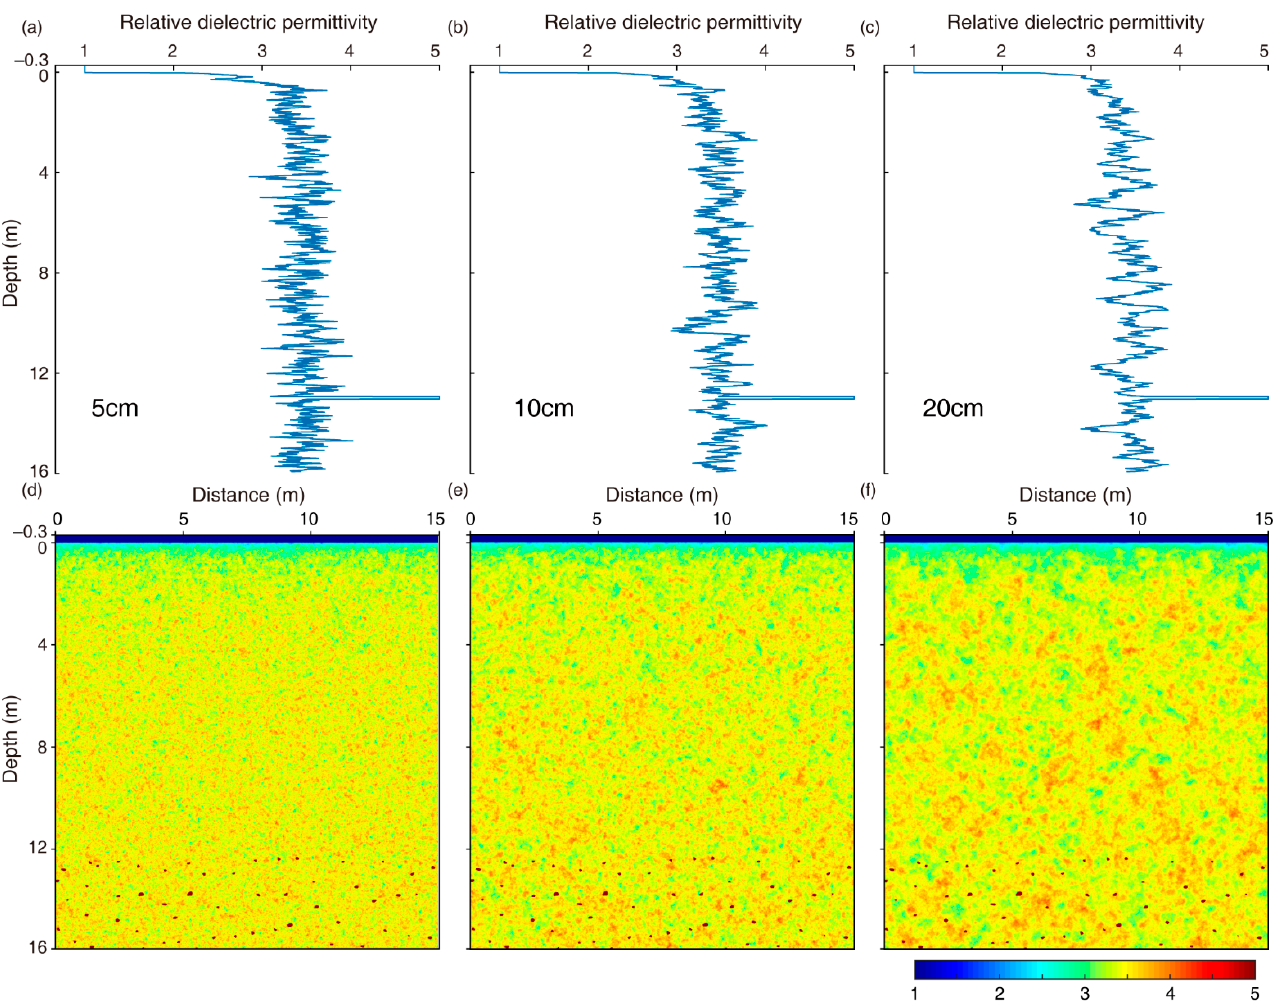
Figure 4. Exponential ACF models with different correlation distances. ( a – c ) Fluctuation of the 1D probe along the center of 2D model. ( d – f ) 2D relative dielectric permittivity models with three correlation distances. The correlation distances were ( a , d ) 5 cm, ( b , e ) 10 cm, and ( c , f ) 20 cm, respectively. The RMS perturbation is 5%.